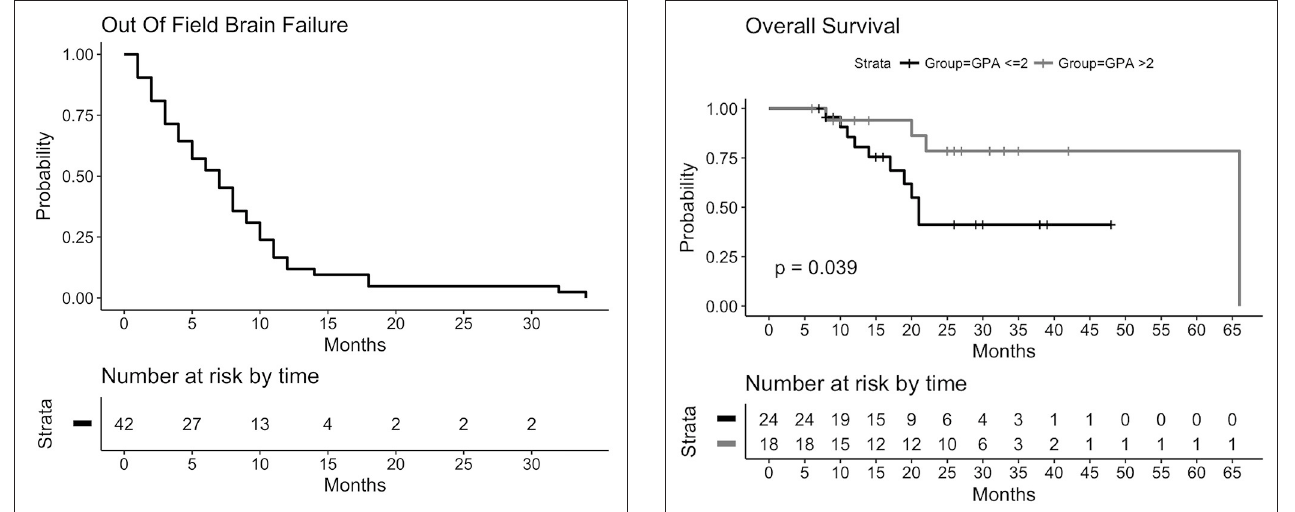
FIGURE 3 | Kaplan-Meier-Plot for out-of-field brain control after 1st treatment course. Censored in case no event occurred or if WBRT had to be administered.